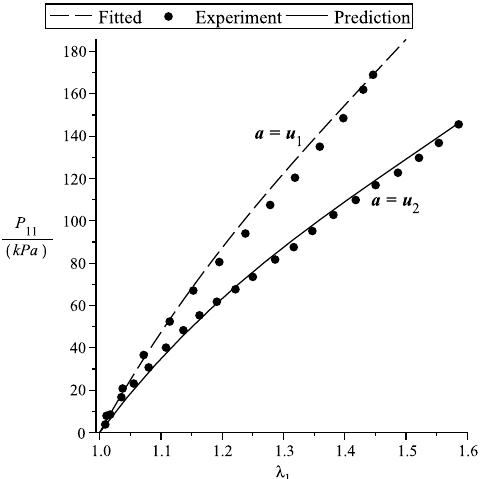
Figure 1. First Piola–Kirchhoff stress vs stretch. Ciarletta et al. [25] fiber reinforced simple tension experiment. µ T = 120 kPa , µ L = 160 kPa , β = 0, d 0 = − 3, d 1 = 2. The experiment data is adapted from